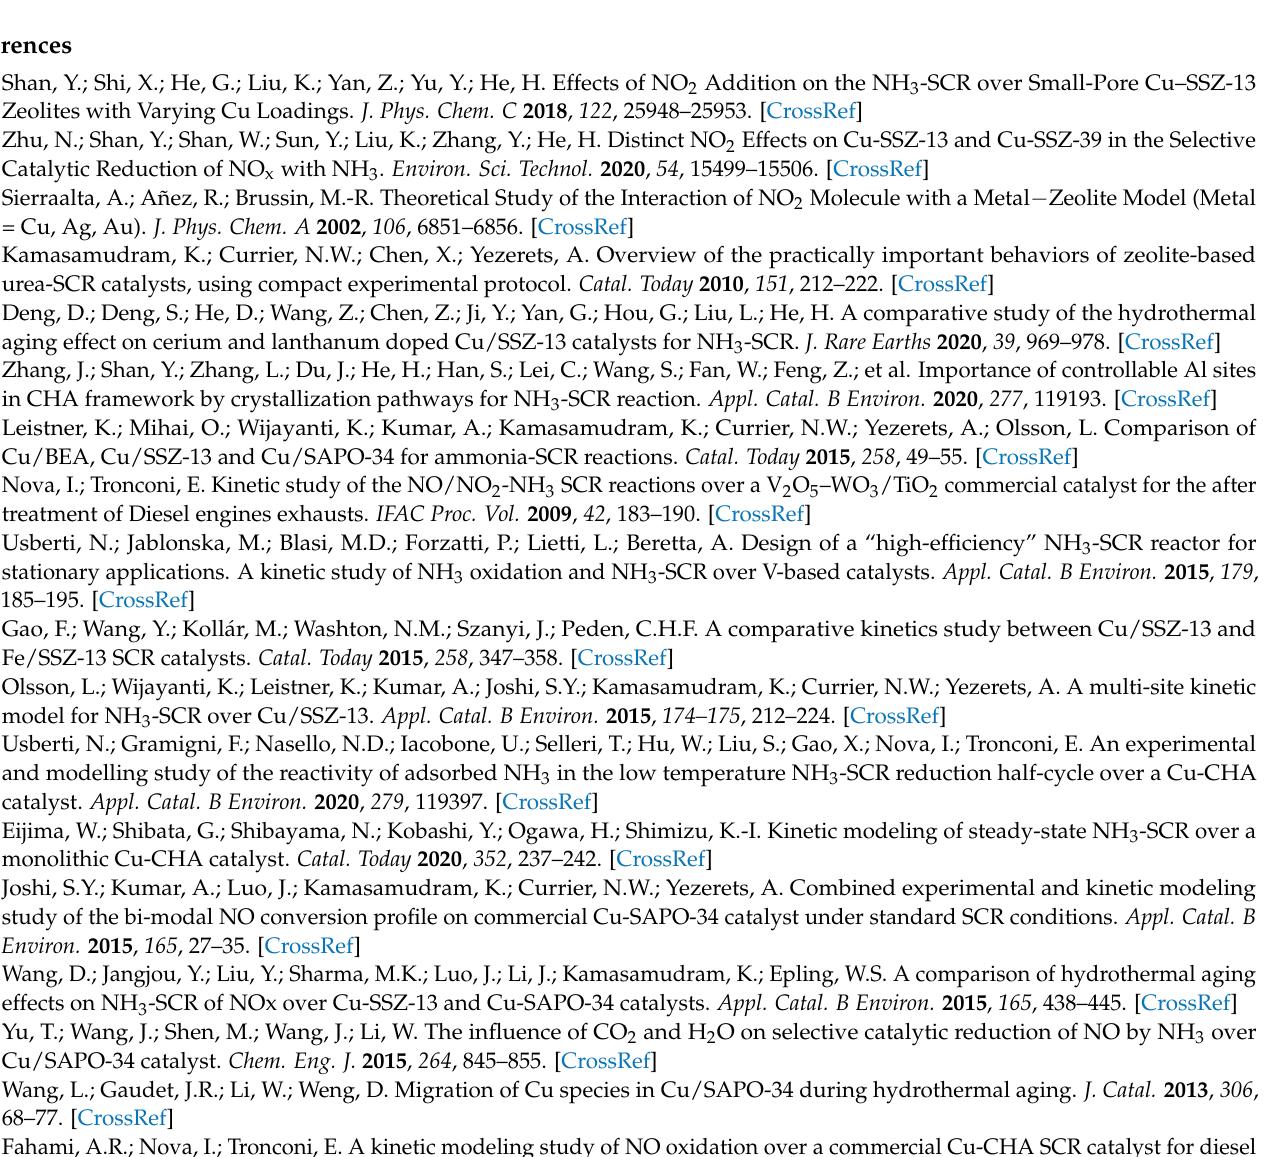
Figure 1 (experiment) and Figure 2 (experiment) are available in